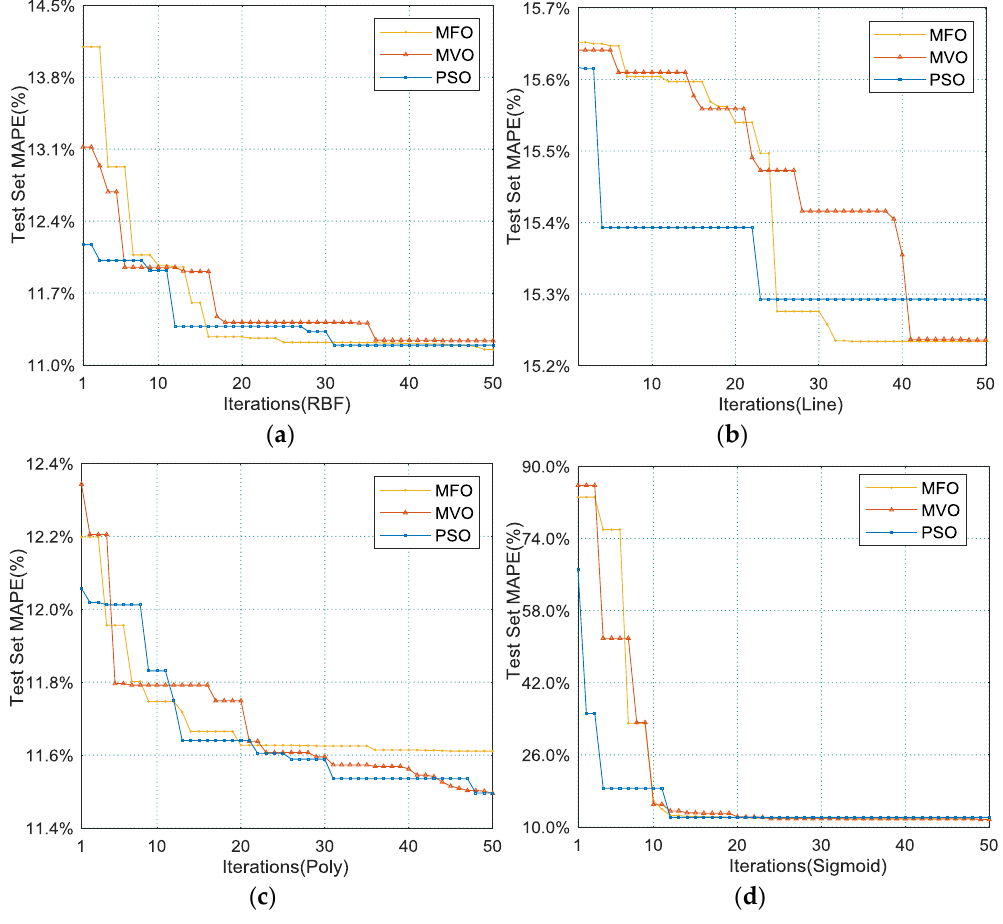
Figure 5. The MAPE curve of the test set. ( a ) Gaussian, ( b ) linear, ( c ) polynomial, ( d ) sigmoid.